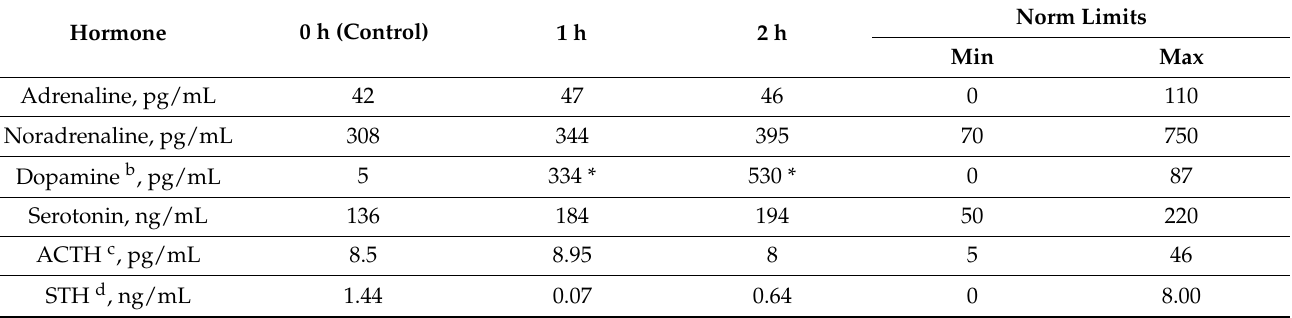
Table 1. Dynamics of hormones in the blood during the test period of a 5.6-mg nicotine pack a